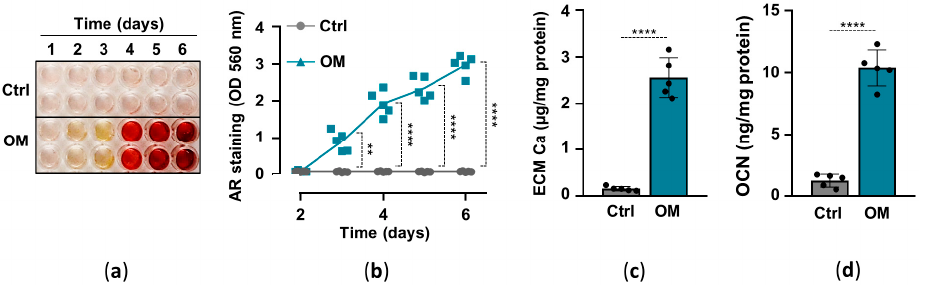
Figure 1. ( a – d ) Confluent HuLECs (passage 5–8) were maintained in control (Ctrl) or osteogenic conditions (OM). ( a , b ) Time course of Ca deposition evaluated by AR staining. Representative staining and quantification from 4 independent experiments are shown. ( c ) Ca content of the HCl-solubilized ECM (day6). ( d ) OCN level in EDTA-solubilized ECM (day6). ( c , d ) Data are expressed as mean ± SD, from 5 independent experiments. ( b ) Multiple t -tests to compare Ctrl and OM at each time point were performed to obtain p values. ( c , d ) t -test was used to obtain p values. ** p < 0.01, **** p < 0.001.